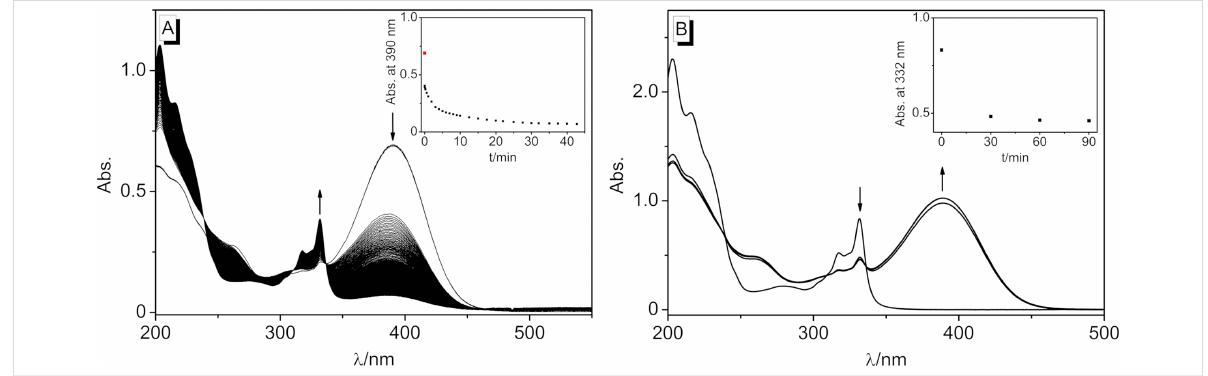
Figure 7: Photometric monitoring of the photoreaction of 3b ( c = 20 µM) to the dimer 4b by irradiation at ca. 450 nm in H 2 O (A) and of the photo- induced cycloreversion of 4b ( c = 20 µM) to the monomer 3b at 315 nm in H 2 O (B).